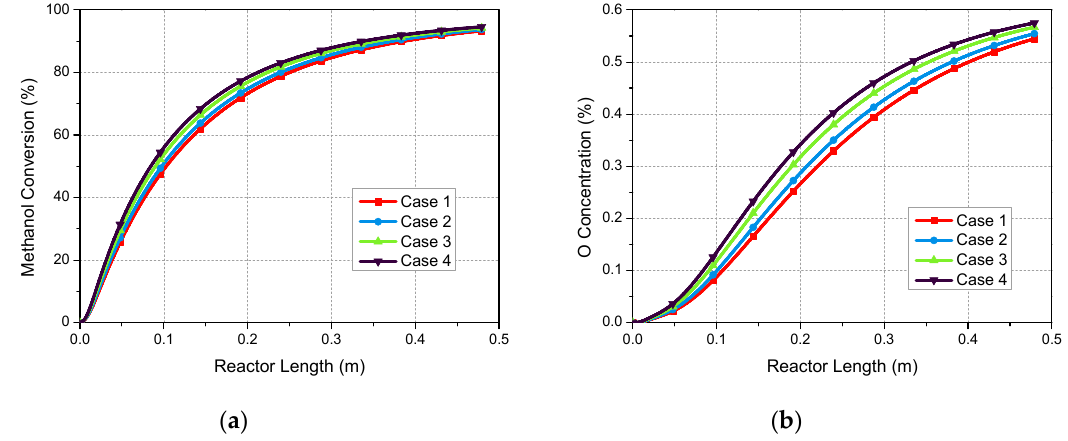
Figure 13. Profiles of ( a ) methanol conversion, ( b ) CO concentration along the length of reactor with different number and pitch of baffles.